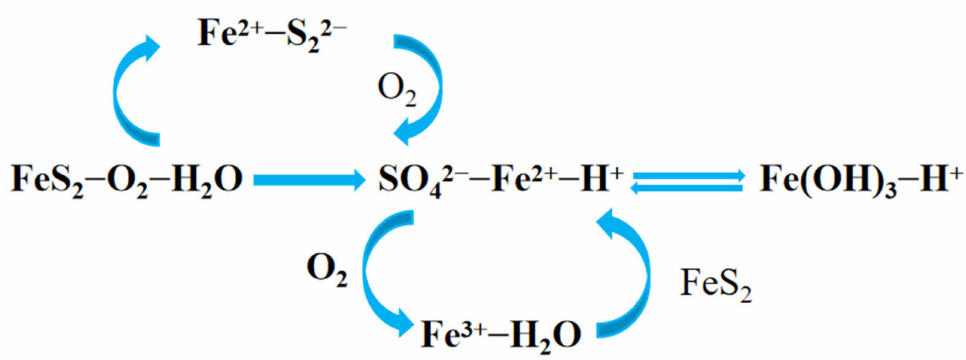
Figure 2. Chemical reactions related to AMD